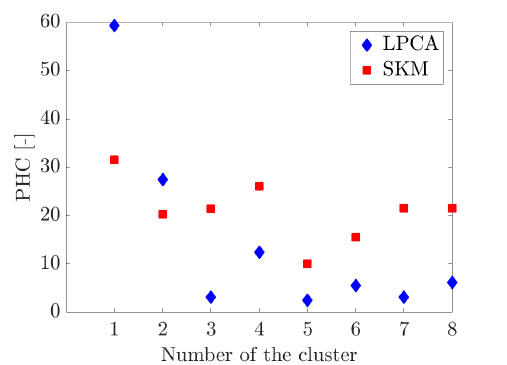
Figure 7. Comparison of the Physical Homogeneity Coefficient (PHC) to evaluate the intra-cluster homogeneity between the SKM clustering and the LPCA clustering, on equal terms of clusters in input ( k =